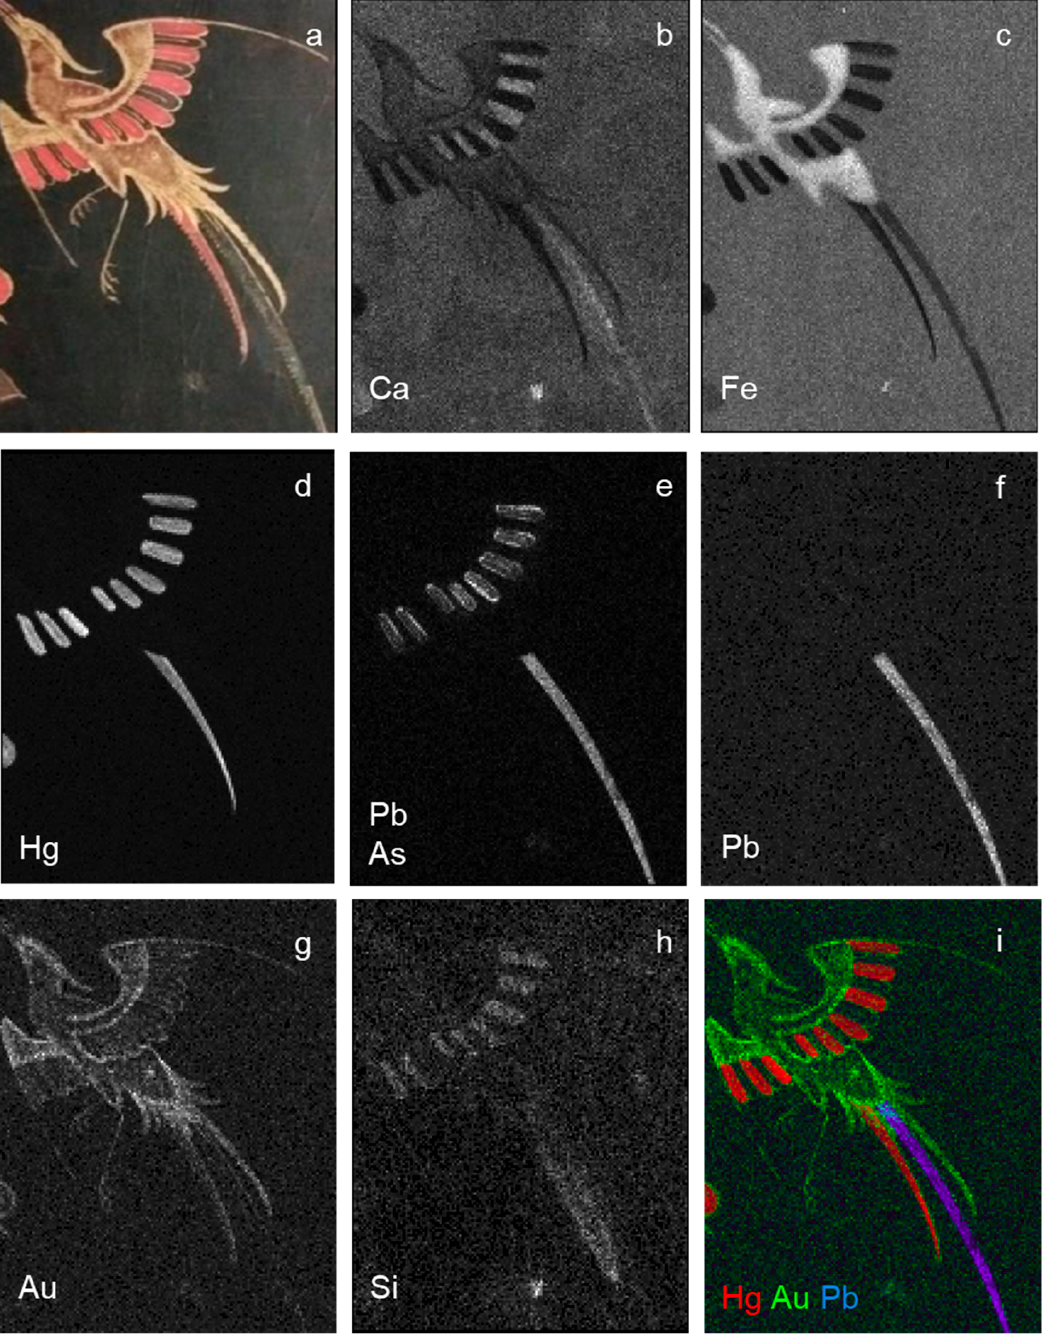
Figure 3. Elemental maps of the second area obtained by the INFN-CHNet MA-XRF scanner. ( a ) Visible. The maps presented are: ( b ) Ca K α transition; ( c ) Fe K α transition; ( d ) Hg L α transition; ( e ) Pb L α /As K α transitions; ( f ) Pb L β transition; ( g ) Au L α transition; ( h ) Si K α transition; ( i ) RGB map of Hg (red), Au (green) and Pb (blue).